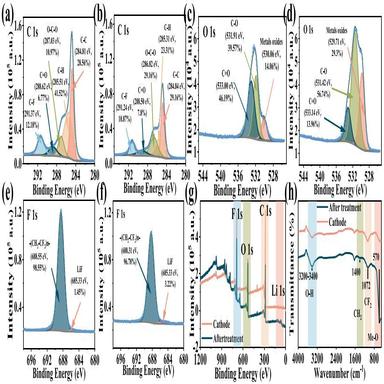
XPS spectra for (a). C 1s of cathode, (b). C 1s of cathode materials after treatment, (c). O 1s of cathode, (d). O 1s of cathode materials after treatment, (e). F 1s of cathode, (f). F 1s of cathode materials after treatment, (g). Wide range and (h). FT-IR spectra of cathode and cathode materials after treatment.